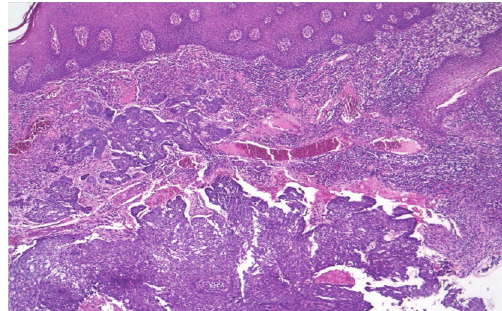
Figure 2: Case 1: The histopathology of the first biopsy specimen confirmed the diagnosis of BCC.